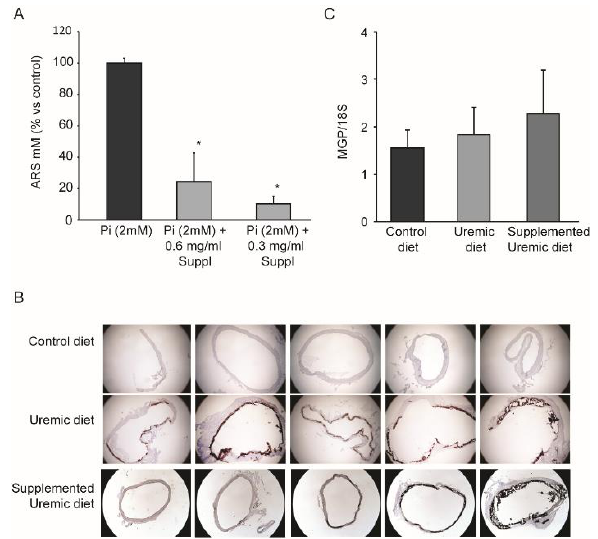
Figure 1. Effect of MK-7 in combination with magnesium carbonate and Sucrosomial ® Iron on vascular calcification. ( A ) In vitro calcification of vascular smooth muscle cells was induced by 2 mM of inorganic phosphate (Pi). The effect of the supplement combination (Suppl.) was tested at 0.3 and 0.6 mg/mL. Extracellular calcium was quantified by alizarin red S (ARS) staining. ( B ) Representative photomicrographs of abdominal aortas stained using the von Kossa method in control (upper panels), uremic (middle panels), and supplemented uremic diets (lower panel). The images are from 5 of 11 rats examined for each group. Although there was some variability between the rats, the induction of vascular calcification was observed by the brown/black staining in the tunica media of the uremic rats compared to the controls. The supplemental diet did not significantly affect the deposition of calcium. ( C ) Matrix Gla protein (MGP) mRNA expression from rat aortas determined by qRT-PCR. Student’s t -test: * p < 0.05 vs. Pi (2.0 mM).